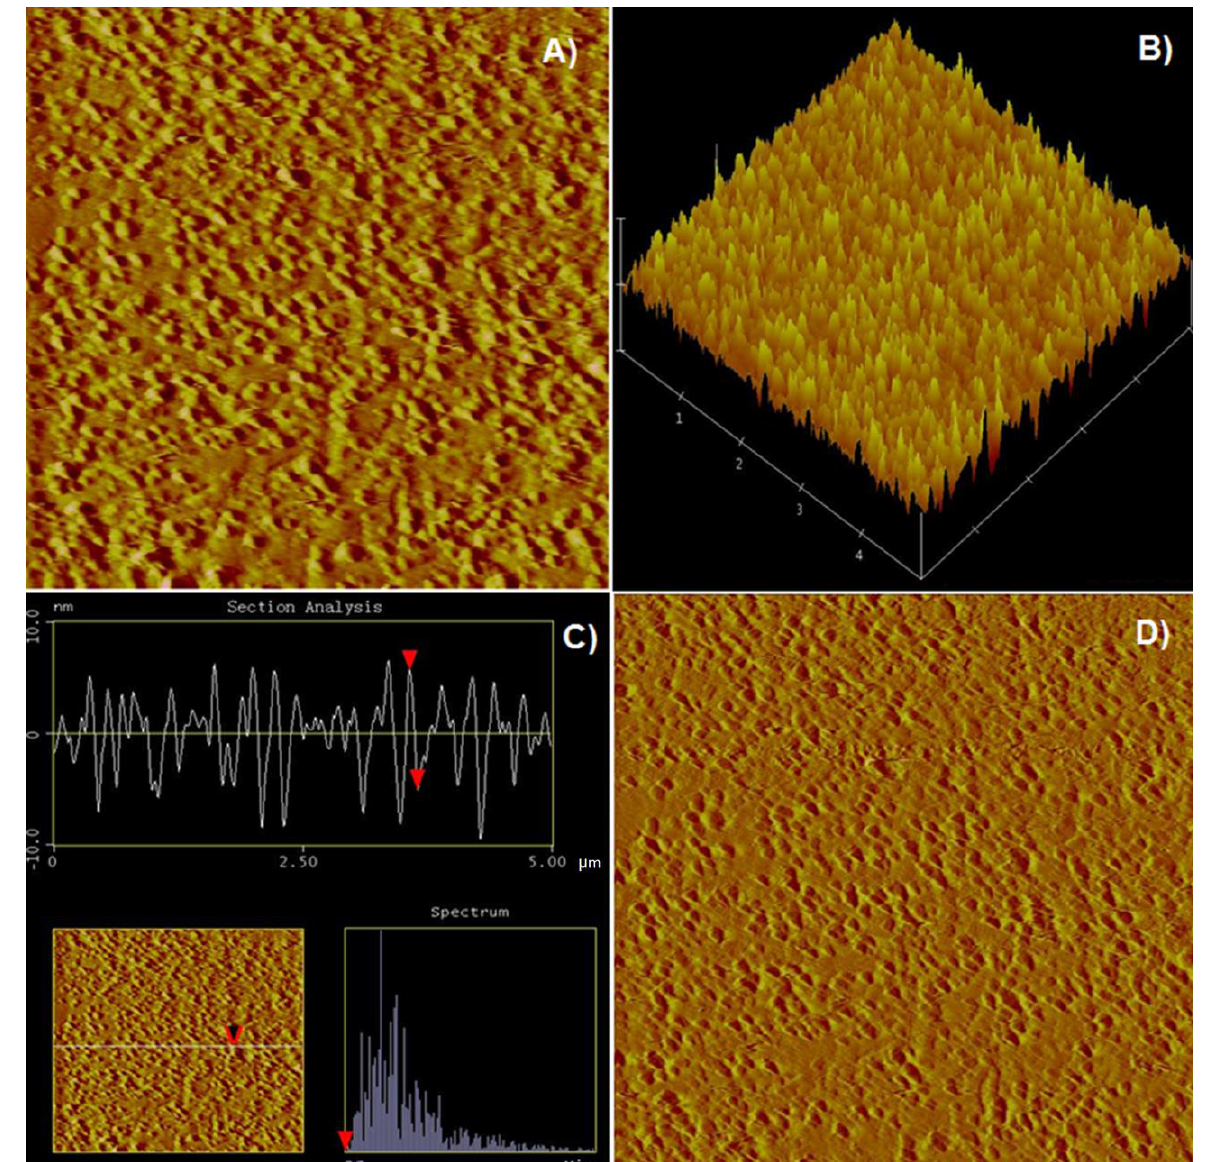
Figure 3. AFM images of a bornite surface soaked in the 5 × 10 − 5 M KEX solution at pH 6 for 10 min. ( A ) The 5 µm × 5 µm height image with a data scale of 20 nm, ( B ) the 3D image, ( C ) the section analysis (the red arrows indicate the top and the bottom of an average asperity) and ( D ) the deflection image with a data scale of 10 nm.